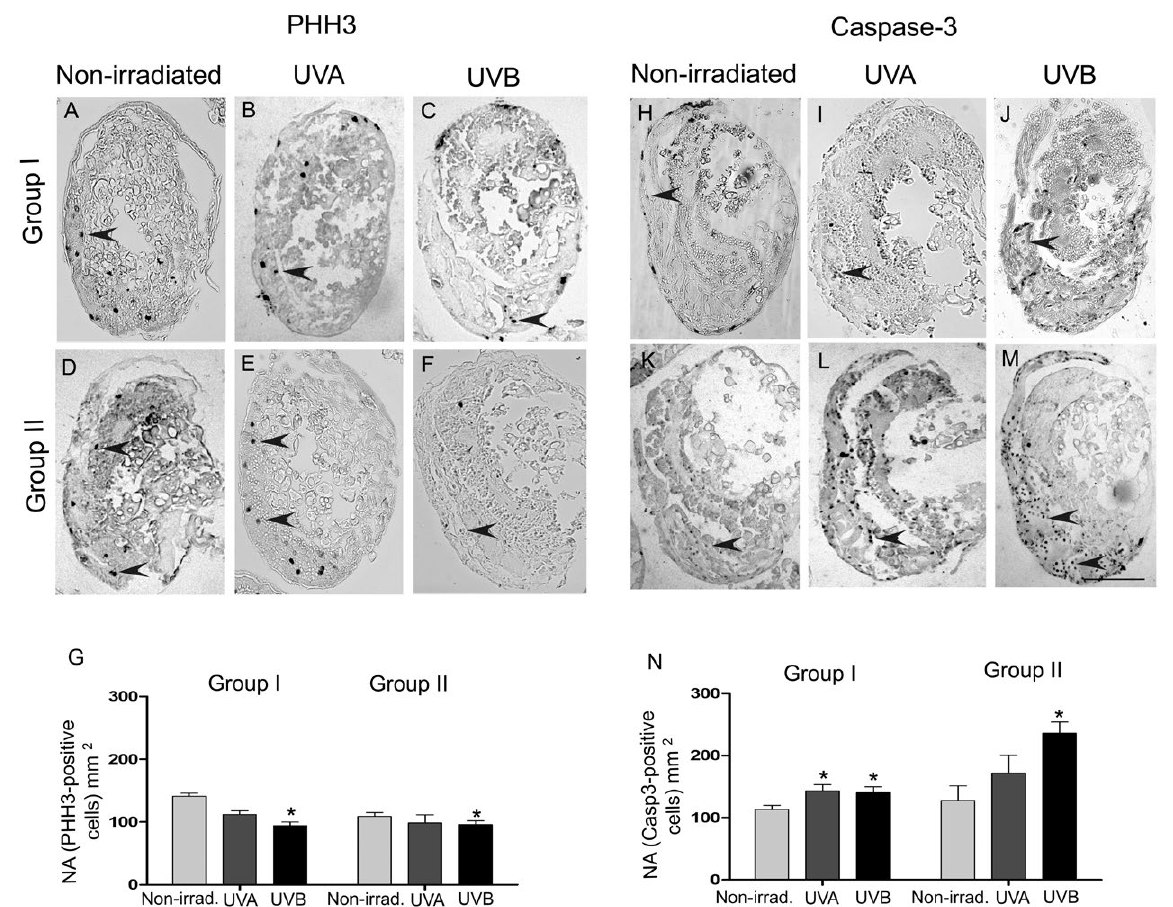
Figure 4. Cell proliferation and cell death labeled with anti-PHH3 (arrowhead) and anti-caspase-3 (arrowhead) antibodies in embryos exposed to UVA and UVB. Numerical density per area (NA) of proliferating cells of embryos from group I and II (A–G). NA of death cells from groups I and II (H–N). Data are presented as the mean ±